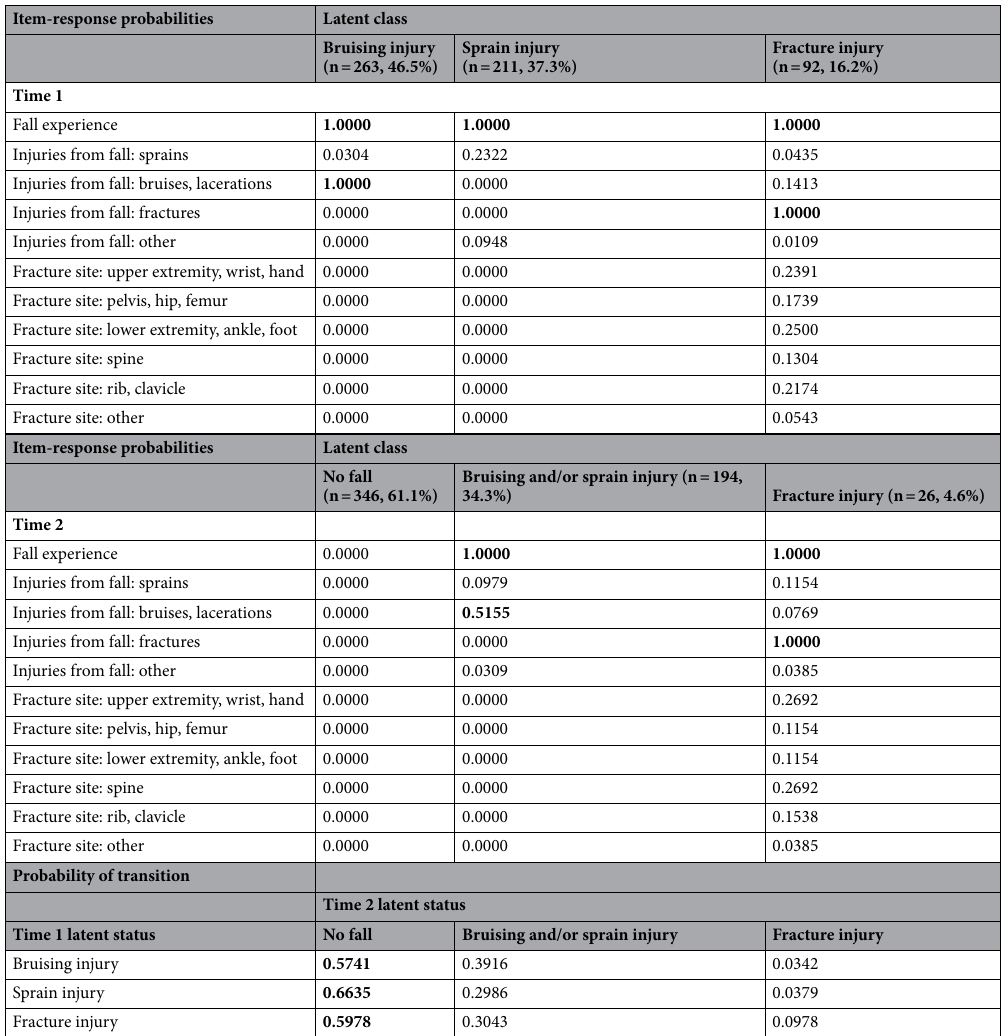
Table 3. Results of the latent class analysis and latent transition analysis of fall injury characteristics. Item response probabilities of > 0.5 are represented in bold.